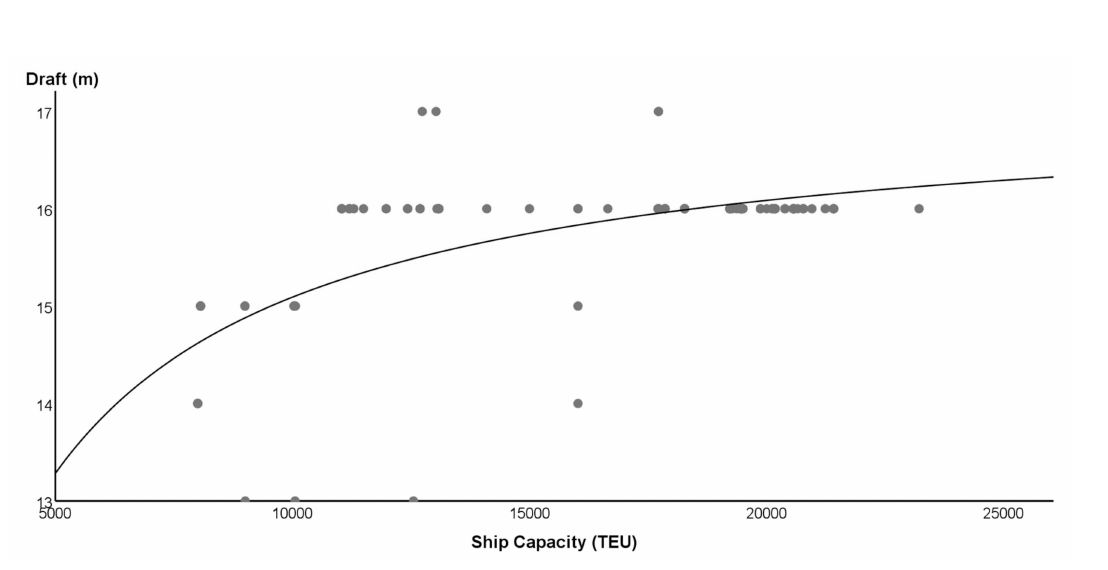
Figure 3. Regression Curve between Ship Capacity and